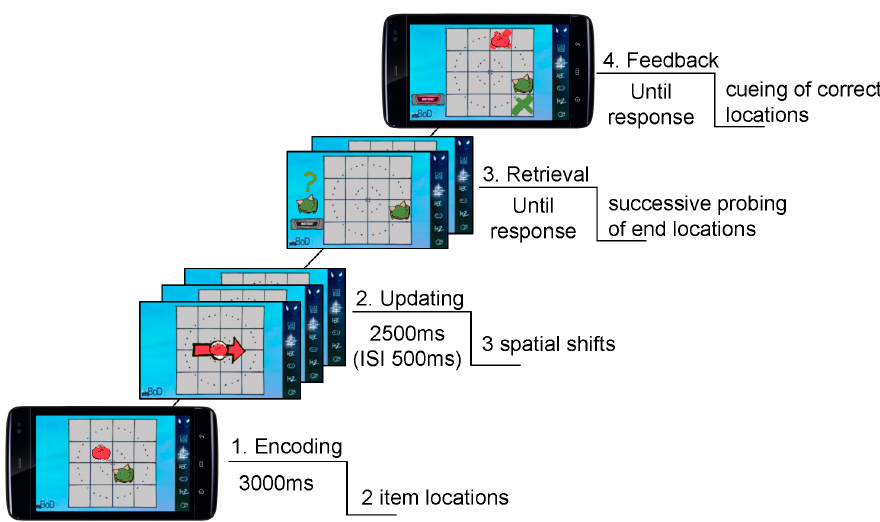
Figure 1. Visuospatial working memory updating task (example showing Load 2). Children had to encode, hold and update the locations of two or three items in visual WM. After updating operations (i.e., sequential mental shifts within a 4 × 4 spatial grid), children were prompted to retrieve the updated locations. Responses were consecutively given to each item by touching on the remembered location (cf. [37]).